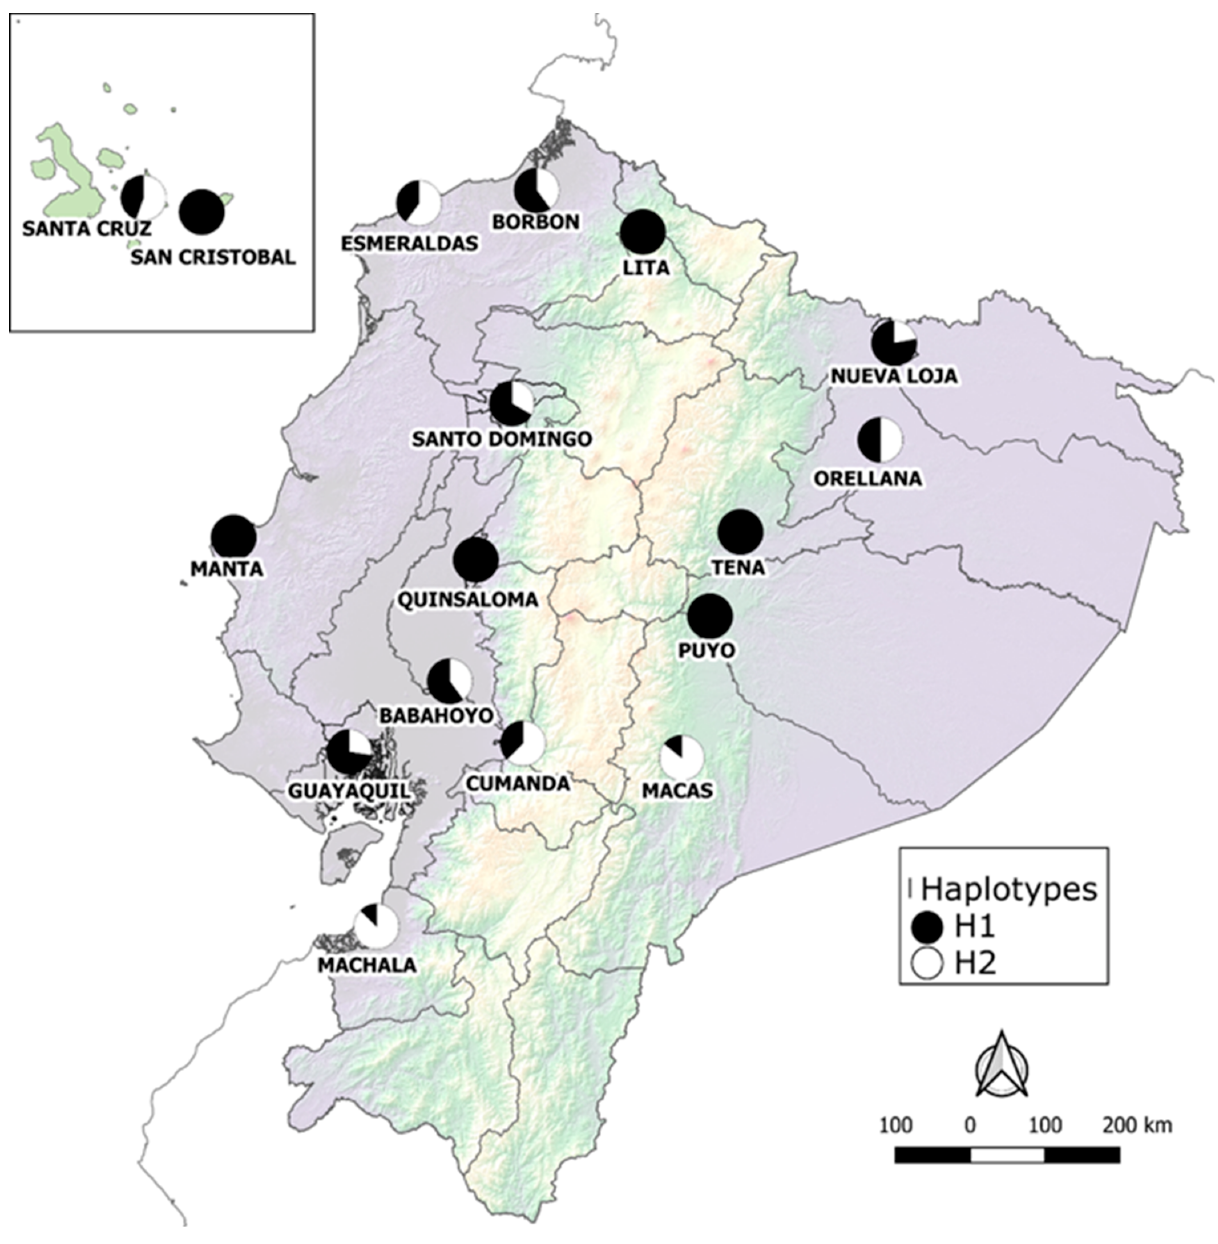
Figure 2. Map of distribution of the two haplotypes of Aedes aegypti populations in 17 localities of Ecuador. Pie charts represent the percentage of haplotype 1 (black) and haplotype 2 (white) present in each locality.